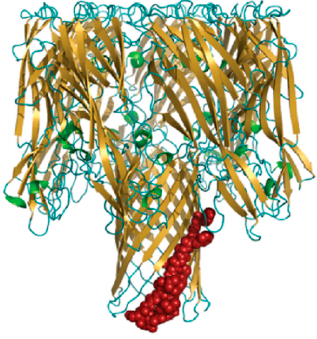
Figure 10. The structure of AT heptameric complex. Adapted from Oscherwitz et al. [141]. The N-terminal 20 amino acids in the cap region of seven monomers interact with